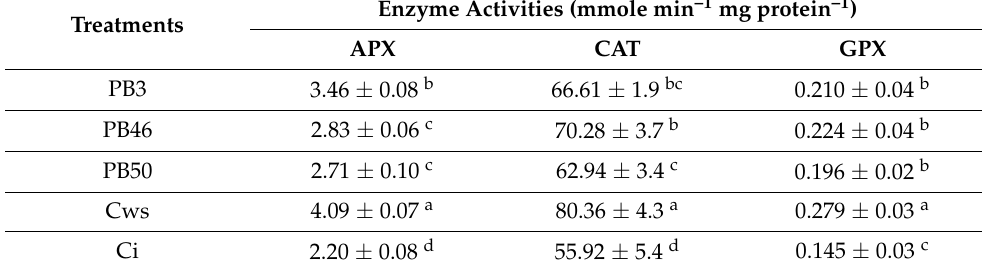
Table 2. Means ± SD (n = 4) of the ascorbate peroxidase (APX), catalase (CAT), and glutathione peroxidase (GPX) enzyme activities in rice leaves according to different treatments and after 10 days of drought stress. PB3, drought stress with B. endophyticus PB3 foliar spray; PB46, drought stress with B. altitudinis PB46 foliar spray; PB50, drought stress with B. megaterium PB50 foliar spray; Cws, drought stress control; and CI, irrigated control. Values with different letters (above the bars) are significantly different according to Duncan’s test ( p ≤